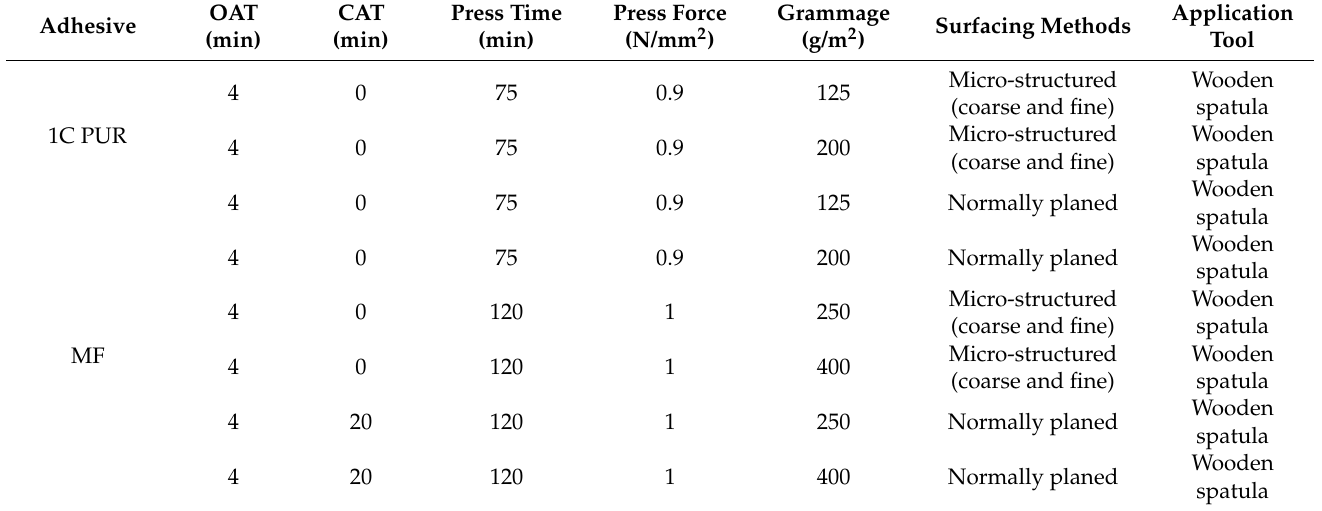
Table 4. Bonding parameters and test specimens.